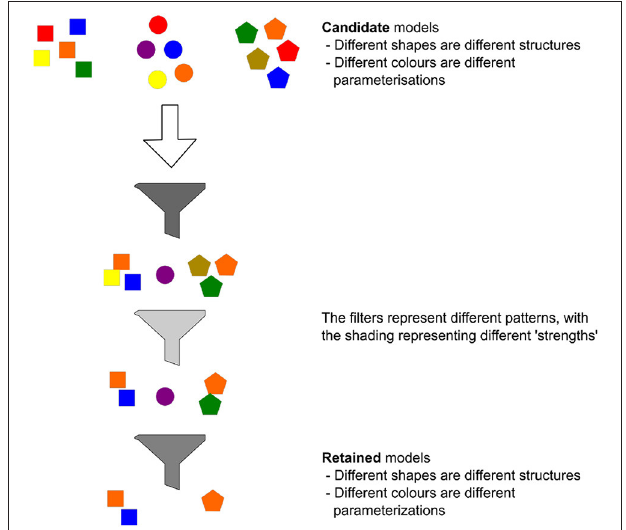
FIGURE 3 | The pattern-oriented modeling (POM) framework (Grimm et al., 2005; Grimm and Railsback, 2012 ) is designed to help modelers implement models that contain sufficient structural detail and are adequately parameterised given the question being addressed. This evaluation is achieved by comparing a suite of model structures (different shapes in figure) and parameterisations (different colors in figure) and assessing them against a set of target patterns (the filters). POM does not seek to find the single “best” model; rather it inherently recognises that there may be a suite of adequate models (lower group of colored shapes) with different structures and